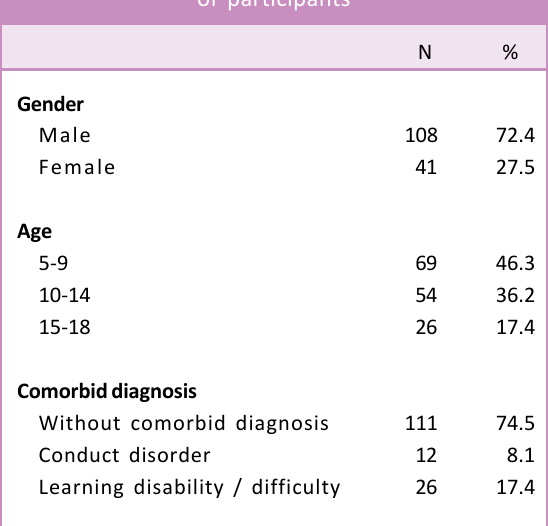
population was 10.4 years. Demographic and